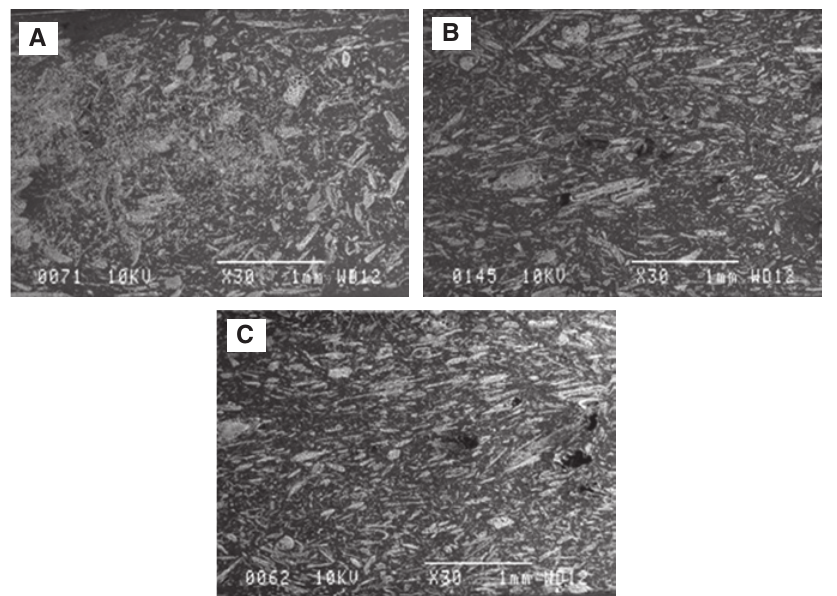
Figure 11 SEM photos of PP triticale composites: (A) 30% triticale without coupling agent, (B) 30% triticale with coupling agent, and (C) 30% triticale with coupling agent and CaO.